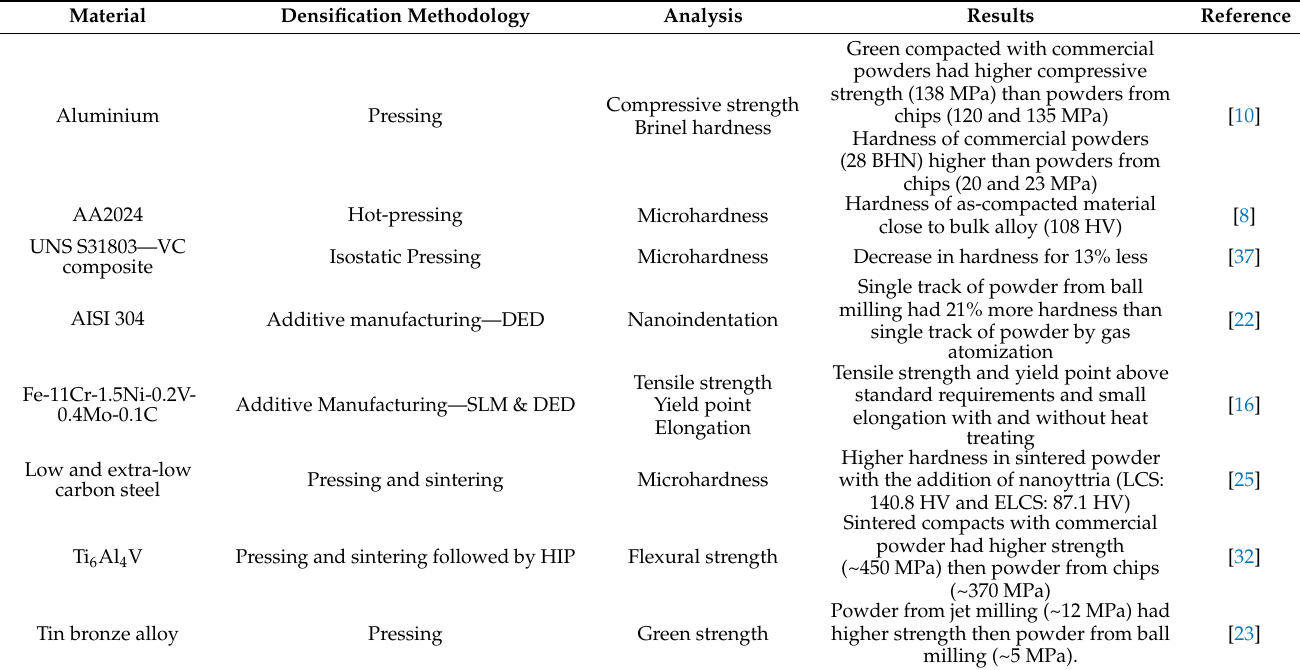
Table 6. Mechanical properties after application of milled